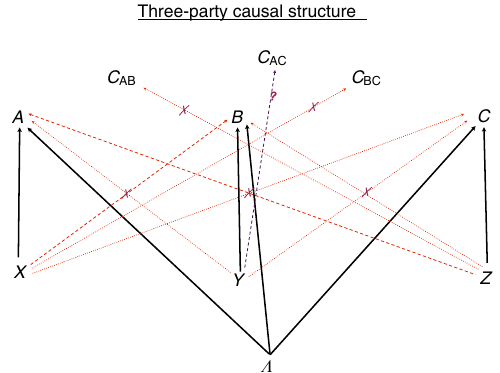
Fig. 1 The causal structure of the three-party Bell experiment. The outputs A , B , C are correlated via a common Λ . The inputs X , Y , Z are chosen freely according to the notion of free choice. The input X cannot signal to change the distribution of a remote party ’ s output B or C , analogously for inputs Y and Z . On the other hand, depending upon the space – time con fi guration of the measurement events, the input may in fl uence the correlations between remote parties ’ outputs without violating causality. In particular, in the measurement con fi guration shown in Fig. 2, the input Y may in fl uence the correlations C AC